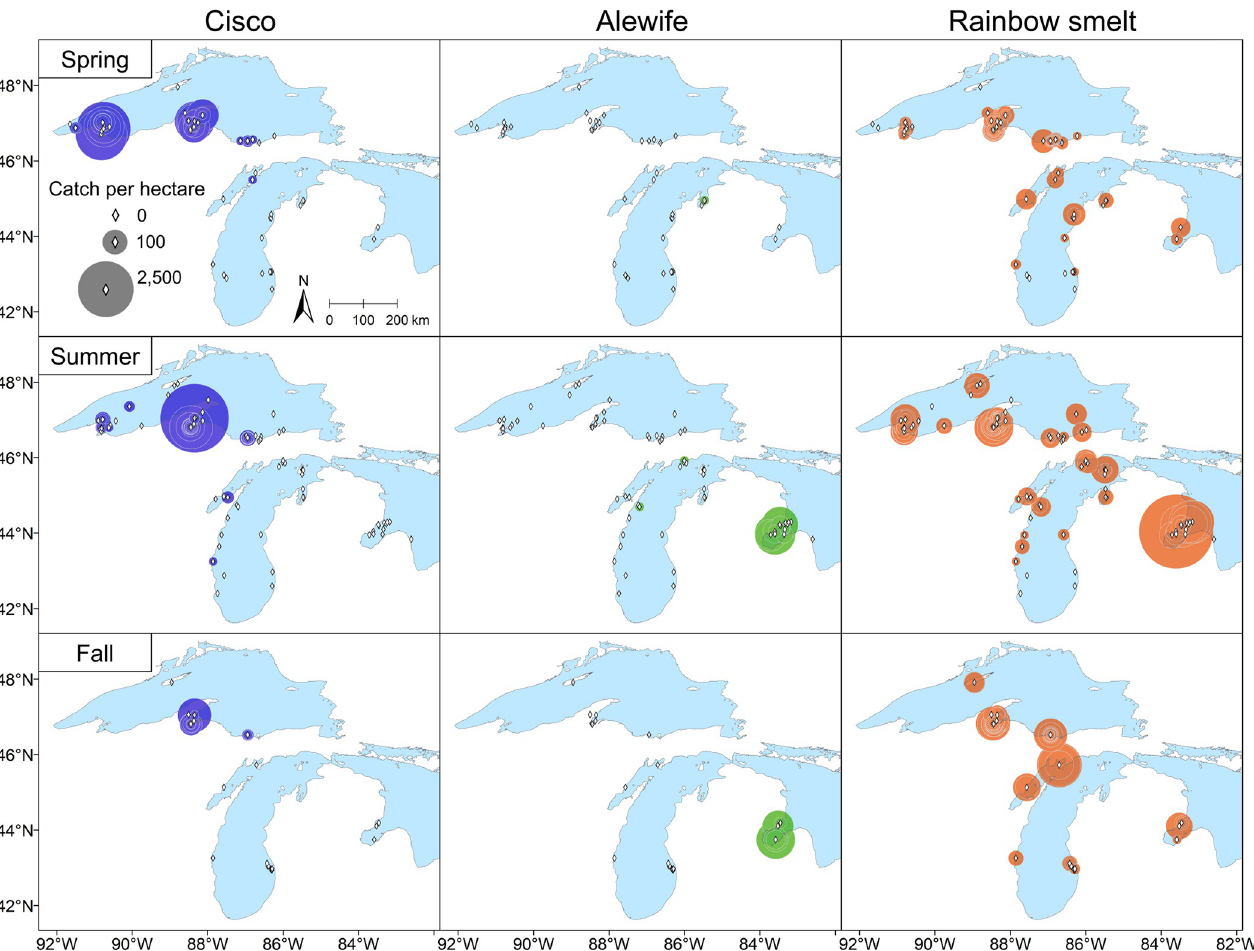
Fig 7. Maps of observed bottom-trawl catch per unit effort (CPUE) for Cisco, Alewife, and Rainbow Smelt in the upper Great Lakes, 1952–1956. The CPUE is expressed as catch per hectare of area swept by the trawl. Data were collected by four-seam trawls with headrope lengths of 9.4–11.9 m. Each diamond represents a survey station. Each circle, centered at a diamond, represents the CPUE at that station, and its area is proportional to the square root of CPUE. Each diamond without a circle around it represents a zero CPUE at that station. The maps were generated with geographic information system (GIS) software ArcGIS version 10.8 (http://www.esri.com/software/arcgis/). The GIS layers of observed bottom-trawl CPUE were generated in this study, while the GIS layer of the Great Lakes outline was obtained from the Great Lakes Aquatic Habitat Framework’s [17] public domain spatial database (https://glahf.org/data/).